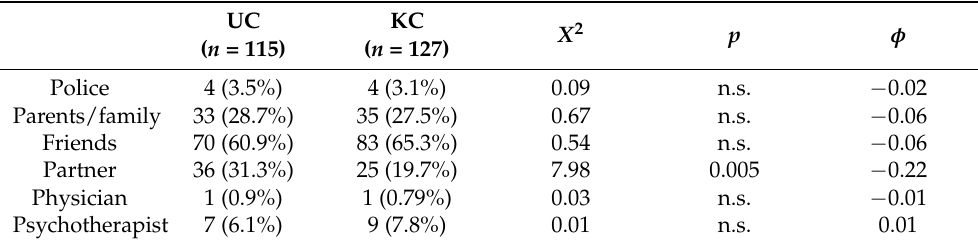
Table 4. Telling someone about the cyberstalking experience: comparison between victims of UC and KC (percentage in brackets).